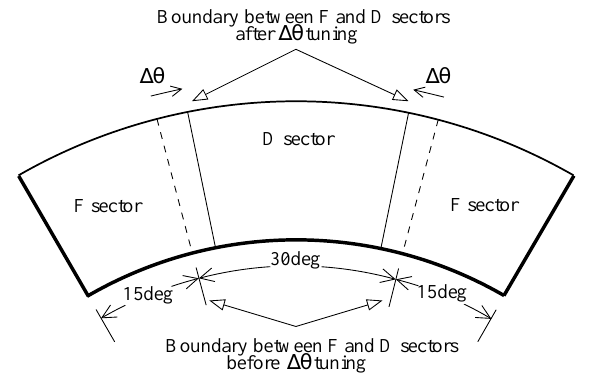
FIG. 4. Schematic of the bending angle modification in Du